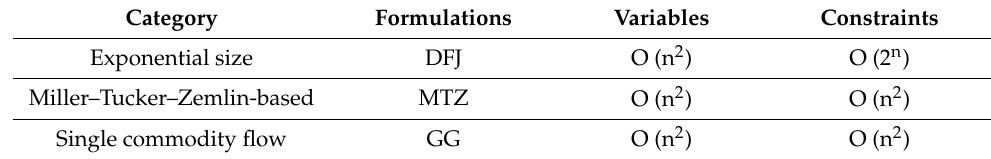
Table 1. Classification of asymmetric traveling salesman problem (ATSP) formulations.